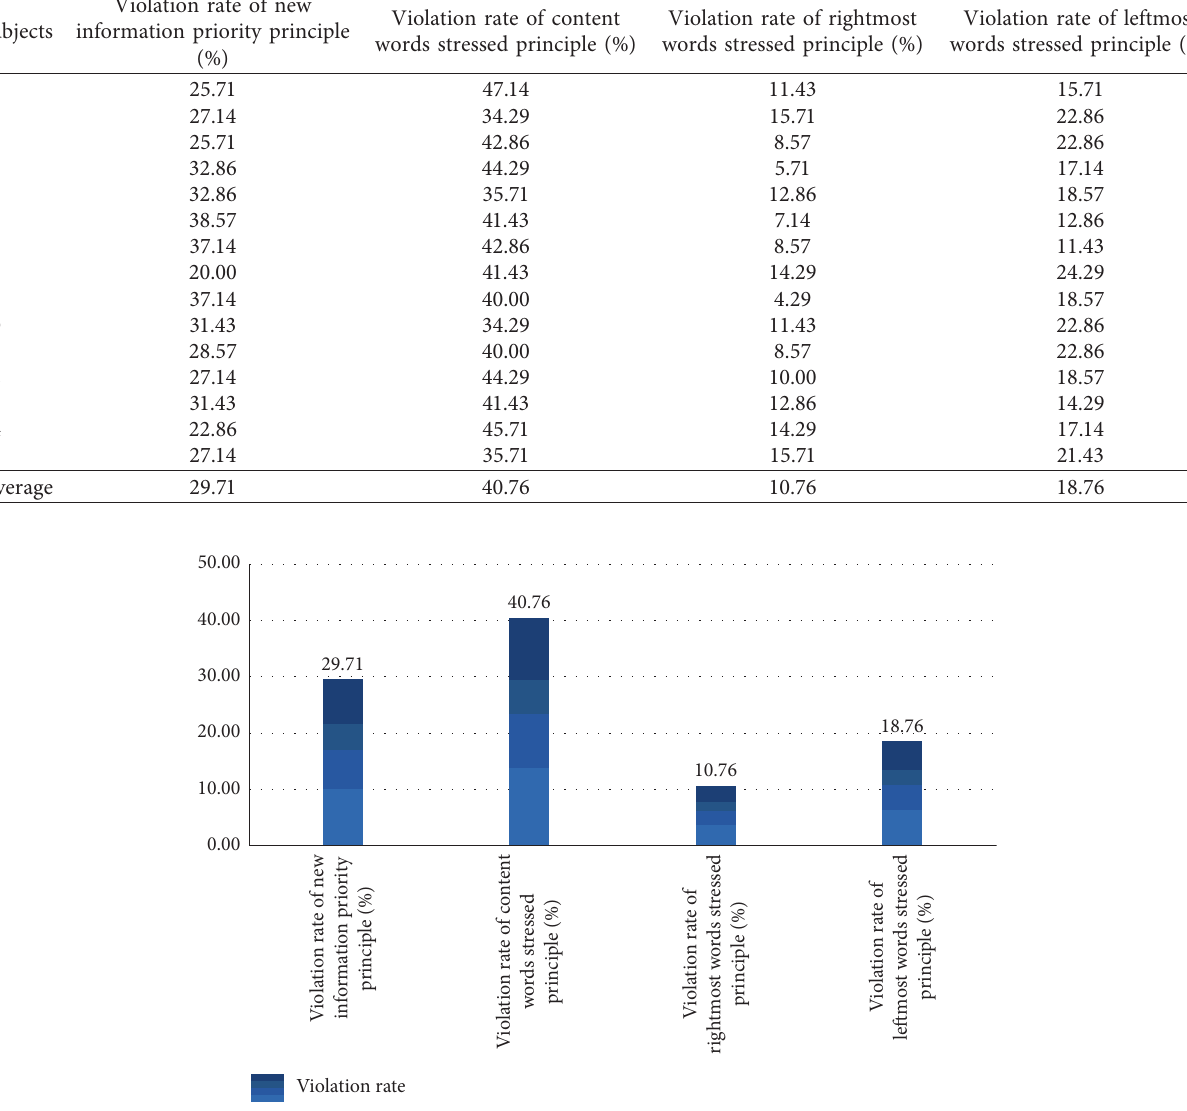
Figure 3: The histogram graph of violation rate of four constraints of nonnative subjects. Table 3: The violation rate of four constraints of native